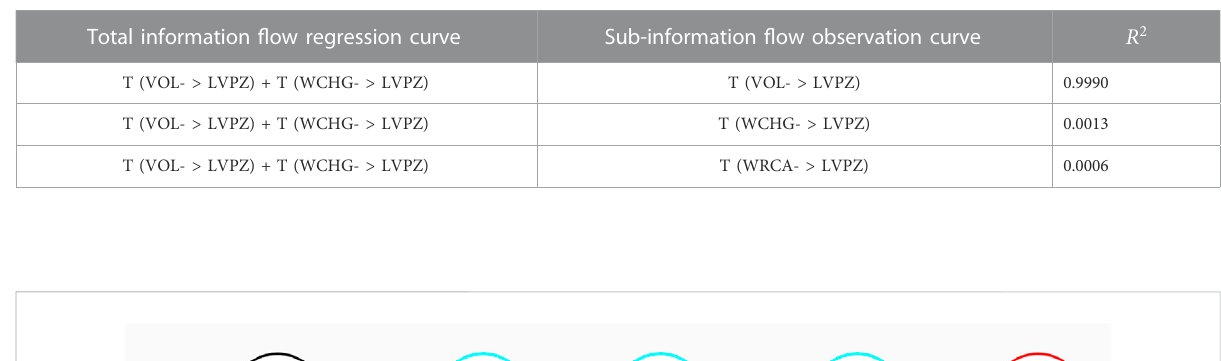
TABLE 3 Goodness of fi t table of 200s of 10% MSLB-IN fault information fl ow.